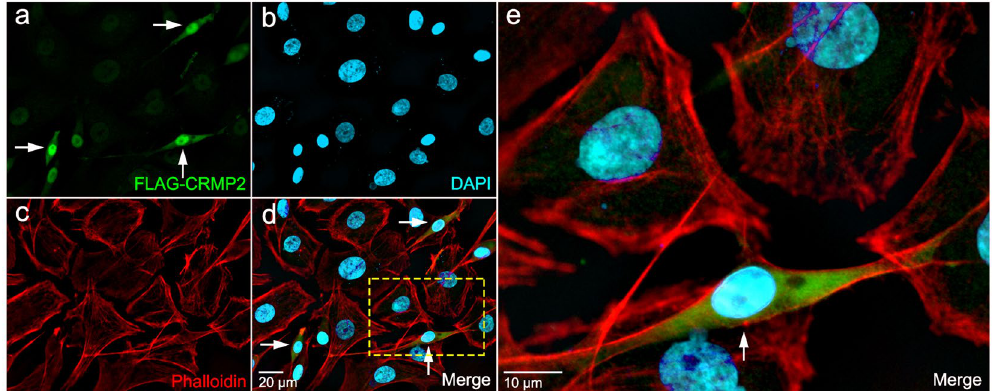
Figure 8. RBM3-associated changes in cell morphology involve CRMP2, a substrate of ROCK. ( a–d ) Images showing rescue of cell polarity and spreading in RBM3 knockdown B104 cells by transfection with a FLAG- CRMP2 construct: ( a ) FLAG-CRMP2 (green); ( b ) nuclei (DAPI, blue); ( c ) F-actin, (phalloidin, red); ( d ) overlay. ( e ) Enlargement of area highlighted by yellow box in d . Arrows in panels a, d and e show FLAG-CRMP2 expressing B104 cells, which have rescued polarity.